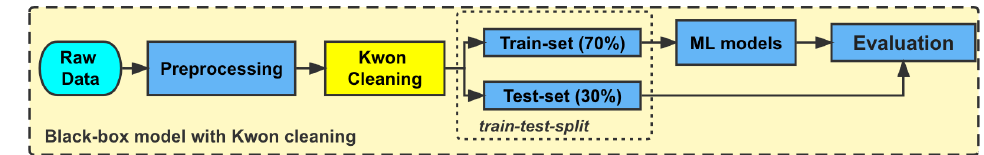
Figure 5. The flow chart of the black-box model with Kwon